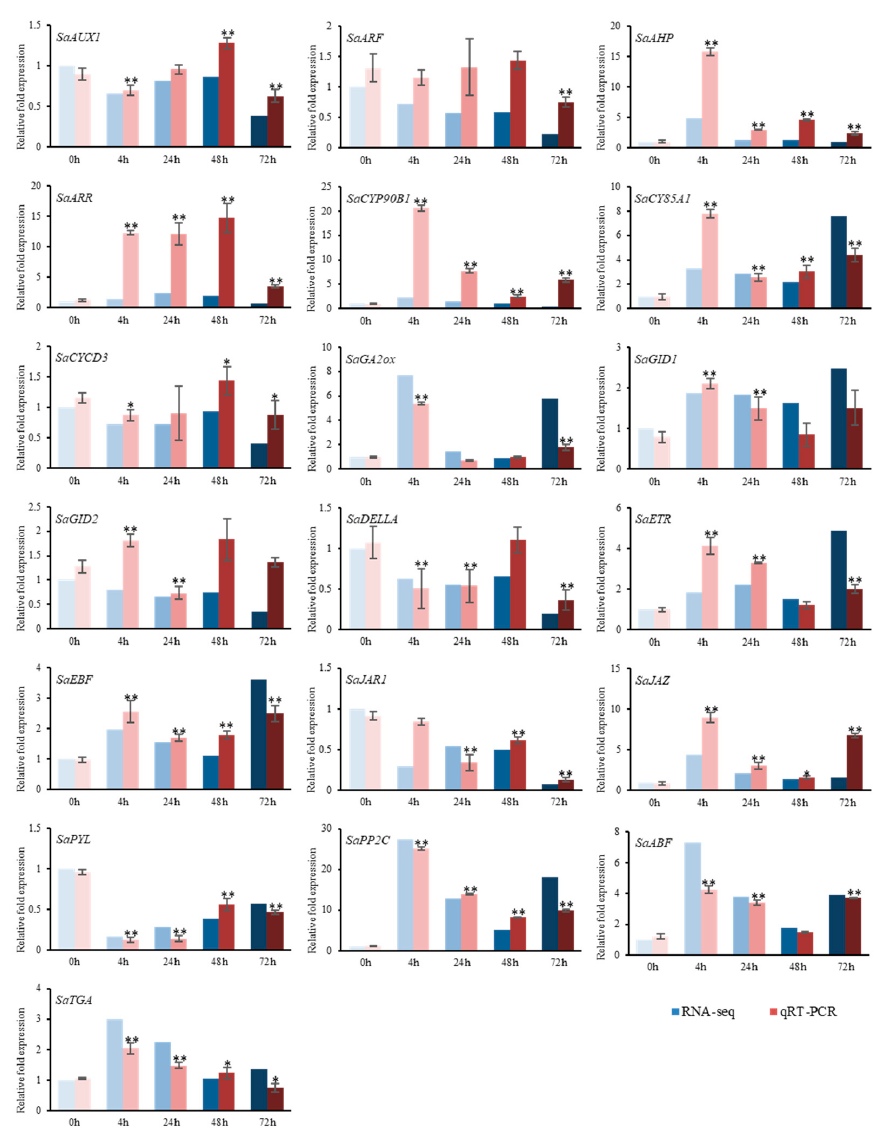
Figure 10. qRT-PCR verification of differentially expressed genes (DEGs). The relative gene expres- sion levels under 1.2% NaCl treatment at different periods. Vertical bar indicates the mean ± SD calculated from three replicates. Statistical comparisons (one-way analysis of variance (ANOVA)) are presented for each variable (** p < 0.01 * p < 0.05).